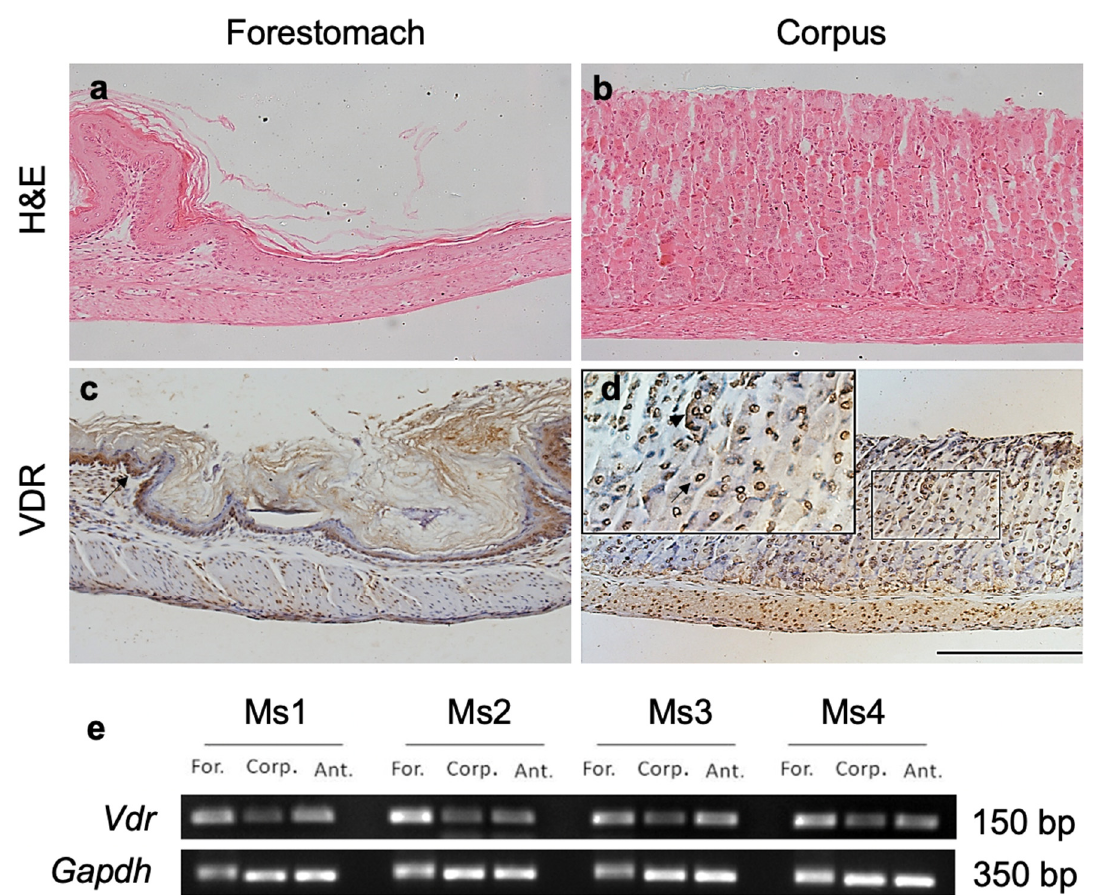
Figure 1. VDR expression in murine stomachs. H&E staining of the ( a ) forestomach and ( b ) corpus and the immunoperoxidase analysis of adult normal mouse stomachs (2–4 months old, n = 4) using a rat polyclonal anti-VDR antibody showing positive signals in both the ( c ) forestomach and ( d ) corpus. VDR expression was observed primarily in the nucleus (( c ), arrow) with an occasional cytoplasmic expression (( d ), arrowhead). Scale bar, 200 μ m. ( e ) Qualitative PCR analysis of Vdr expression in four adult normal mice (Ms1–4) produced bands in the forestomach (For.), corpus (Corp.) and antrum (Ant.) with the most intense bands observed in the forestomach. Gapdh was used as an internal control, full figure please see Supplementary Materials File 1.